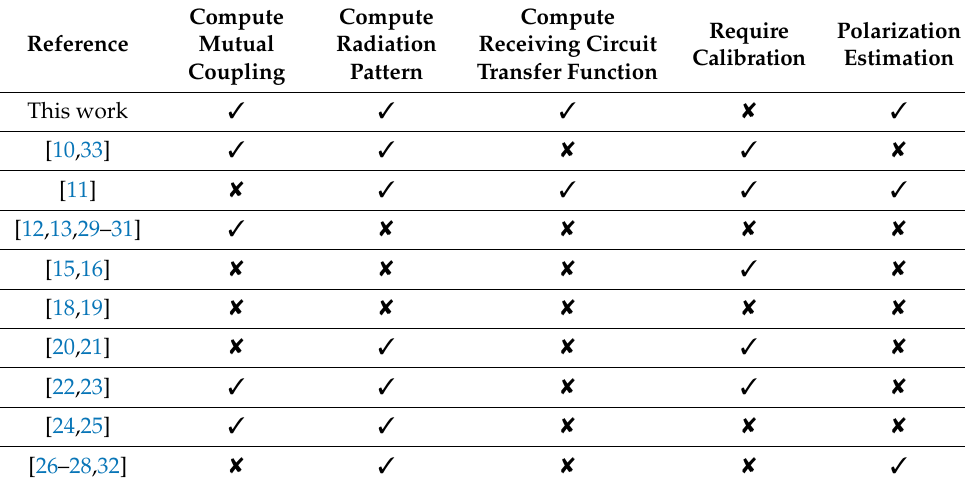
Table 1. Comparison between the proposed formulation and other